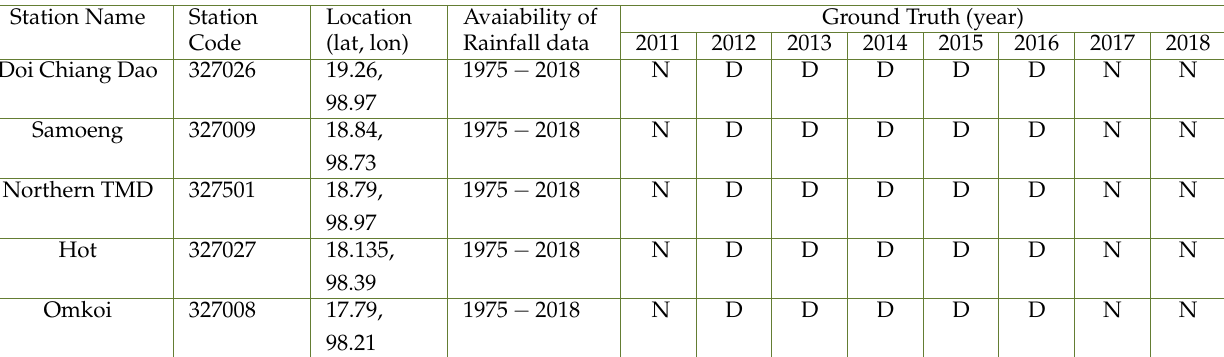
Table 1. Availability of rainfall data and drought ground truth information in Ping river basin.